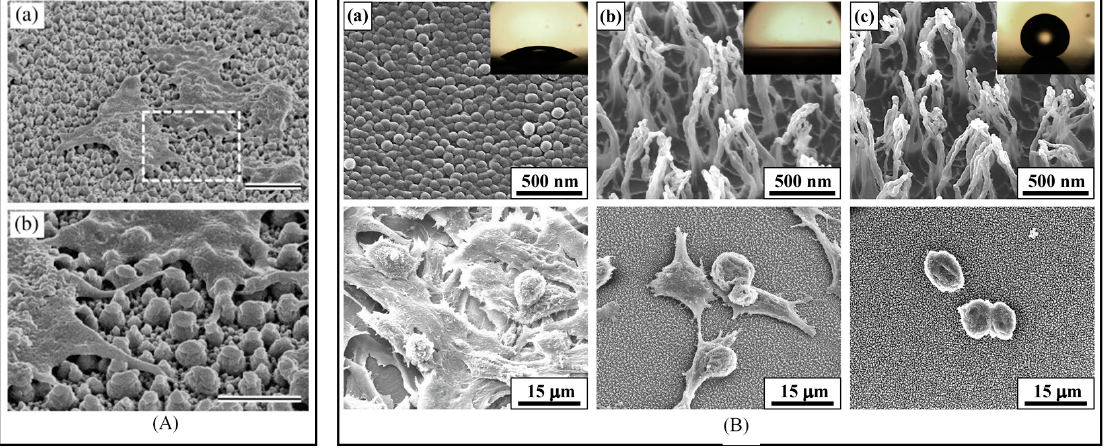
Figure 4. Plasma processing for bioapplications. ( A ) SEM image of adherent platelets on “F-DLC on dual.” (a) The outer shape of adherent platelet on dual rough surface and (b) detail of contact between platelet pseudopodia and micron-nano posts. Bar indicates (a) 1 µ m and (b) 2 µ m. Reprinted with permission from [92]. Copyright Elsevier 2013; ( B ) SEM images of (top) plasma-treated surfaces and (bottom) the adhesion behavior of mouse liver cancer cells on (a) a hydrophilic surface after 1 min of oxygen plasma etching; (b) a hydrophilic surface after 30 min of oxygen plasma etching; and (c) a hydrophobic surface after 30 min of oxygen plasma etching. The insets show the corresponding optical images of water droplets on each surface. Reprinted with permission from [99]. Copyright RSC 2013